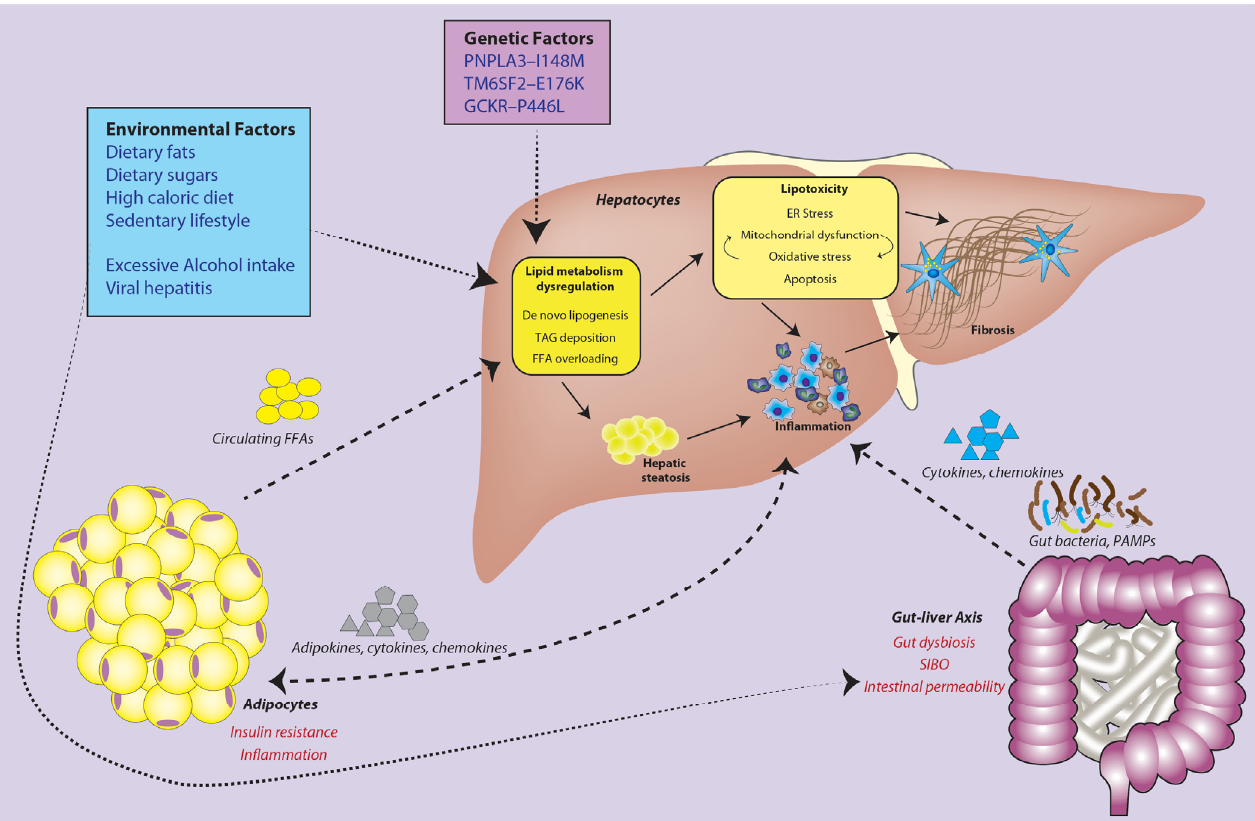
Figure 3. Summary schematic of MAFLD pathogenesis.